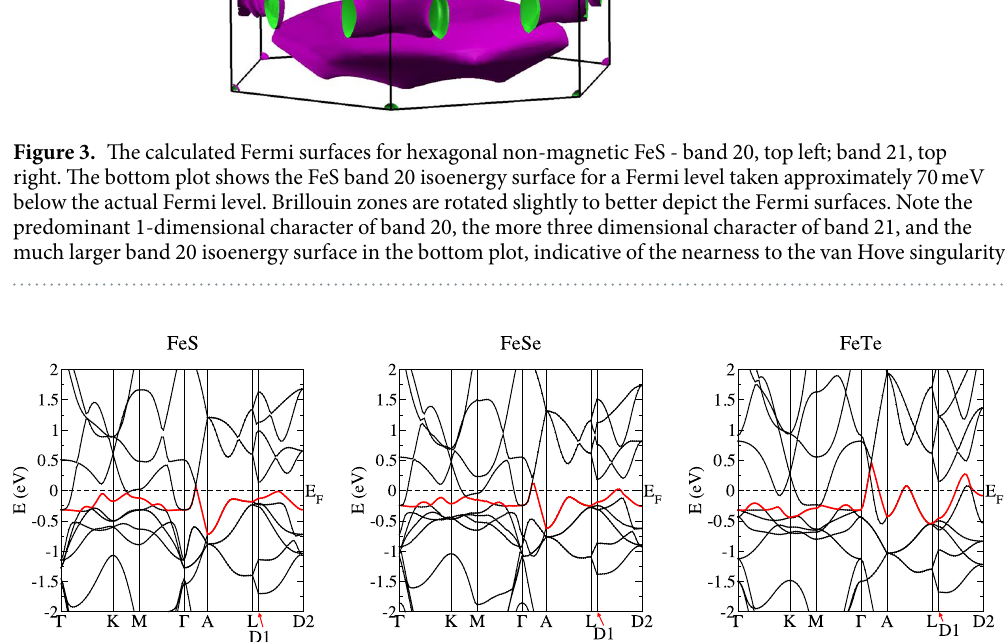
The notions of the dimensionality of FeS bands 20 and 21 can be more precisely quantified by considering the individual DOS of these two bands. We plot this in Fig. 5, along with band 20 and 21 from the tetragonal phase. The DOS for the hexagonal band 20 is narrow and sharply peaked, while that of band 21 is much broader and shorter. Indeed, the bandwidth of band 20 is just 0.054 Ryd while that of band 21 is 0.123 Ryd, or more than twice as large. This is again related to the shorter Fe-S nearest neighbor distances (relative to Fe-Fe nearest neighbors), widening the band width, along with the six-fold Fe-S coordination, relative to the two-fold Fe-Fe coordination. For the tetragonal phase there is no such subdivision of bands of different dimensionality, due to the crystal structure in which c-axis conduction is severely inhibited due to the gap between layers. We note that the specific shape of the hexagonal band 21 DOS in fact bears a strong resemblance to a three-dimensional tight-binding DOS, which has a central plateau, while the tetragonal band 20 and band 21 DOS both bear a resemblance to a 2D tight-binding DOS, which is strongly peaked in the center of the band. It is of interest that the tetragonal band DOS curves have long “tails” and in fact much larger bandwidths than the